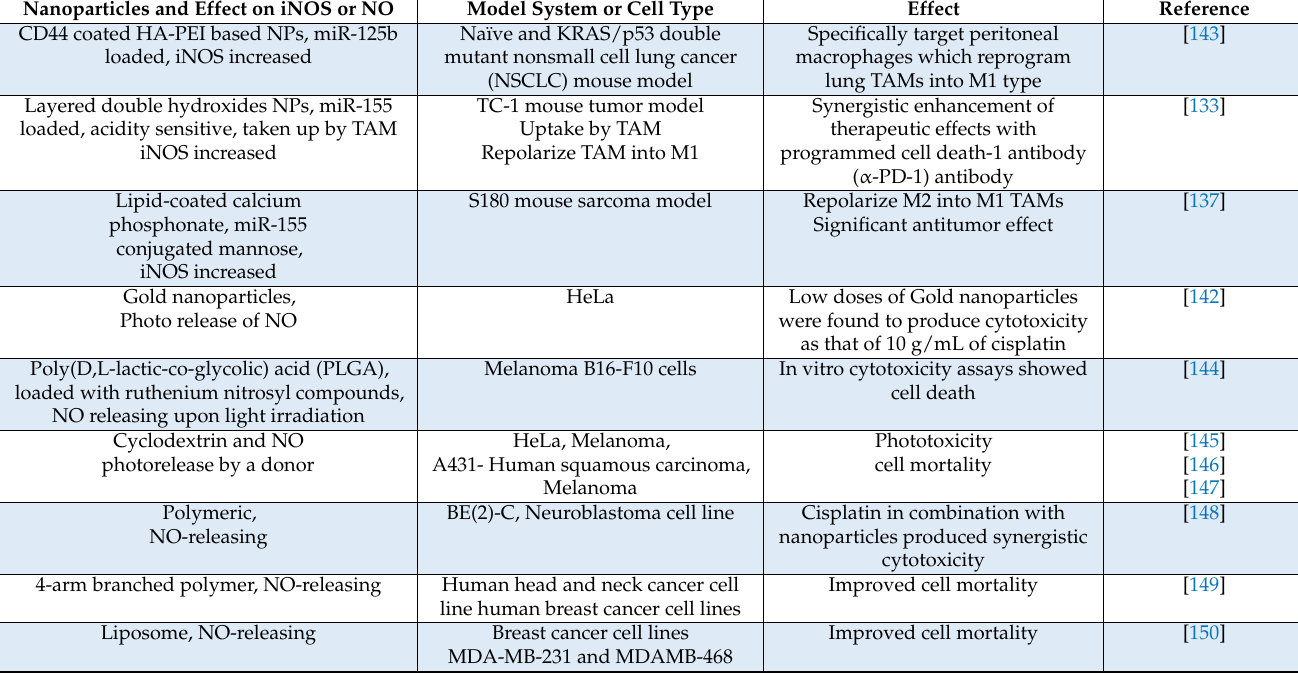
Layered double hydroxides NPs, miR-155 loaded, acidity sensitive, taken up by TAM iNOS increased